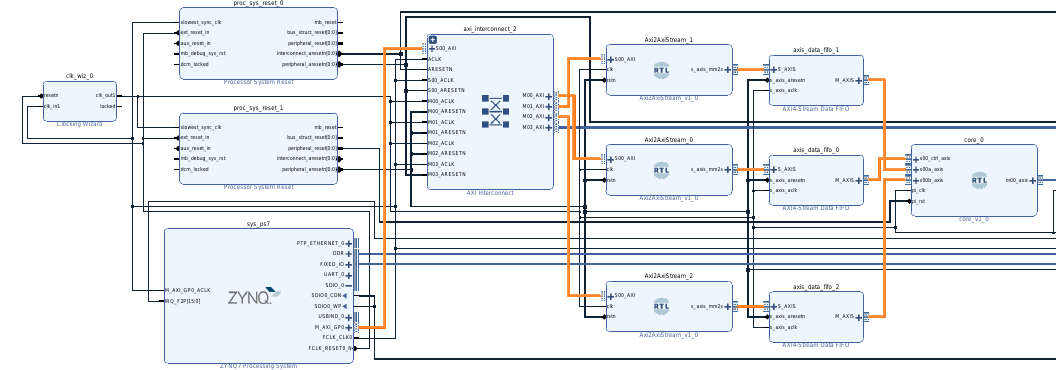
Figure 7. Data-flow diagram for operation of data-writing to MPA coprocessor.